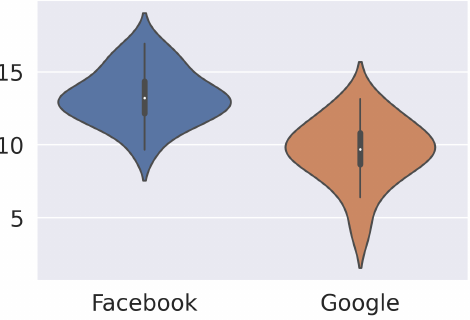
Figure 2. Per-cent increase in mobility reduction during the hard lockdown, with respect to mobility during regular lockdown. Distribution includes the values from all 17 Spanish regions.